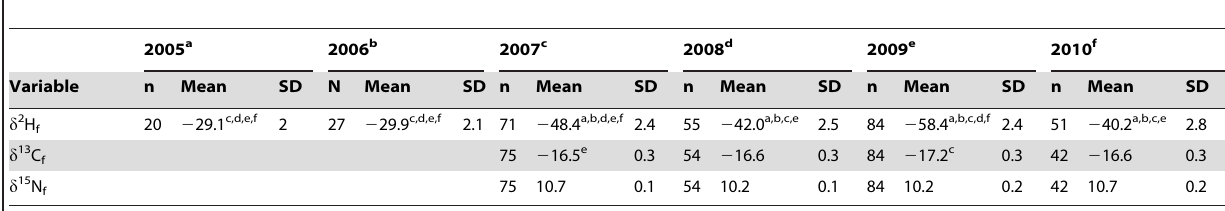
Table 1. Comparison of the multi-isotopic composition ( d 2 H, d 13 C, d 15 N) of Aftrotropical grown house martin feathers from birds breeding in The Netherlands from 2005 to 2010.